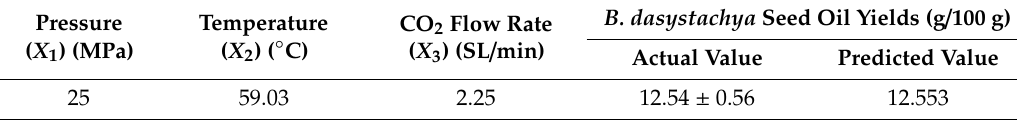
Table 4. Predicted and experimental values of the responses at optimum